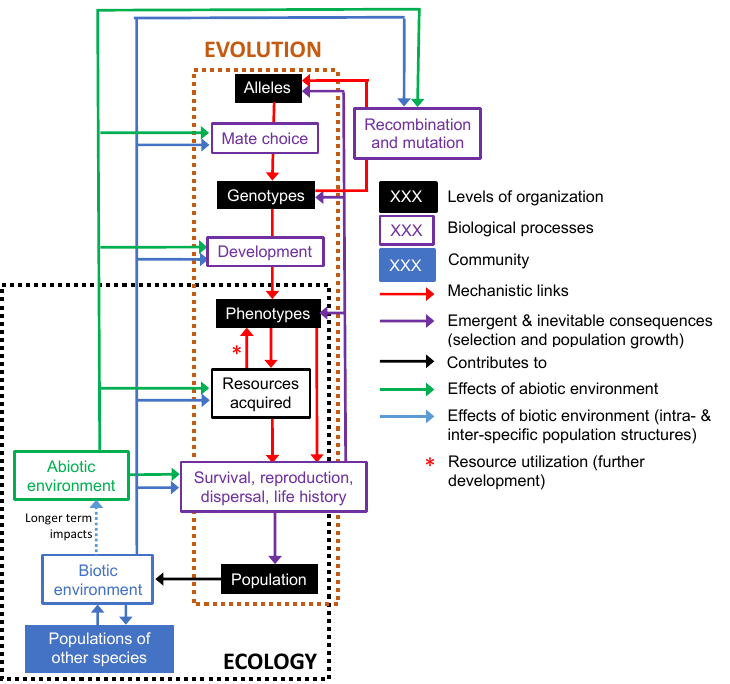
Figure 2. Complex eco-evolutionary feedbacks can arise from the dynamics of distributions of alleles, genotypes and phenotypes (levels of biological organization). These levels are mechanistically linked by key biological processes. Mate choice determines how alleles form genotypes in offspring, with development determining how phenotypes develop from genotypes. Phenotypes impact which resources individuals acquire and can influence survival, reproduction, dispersal and life history